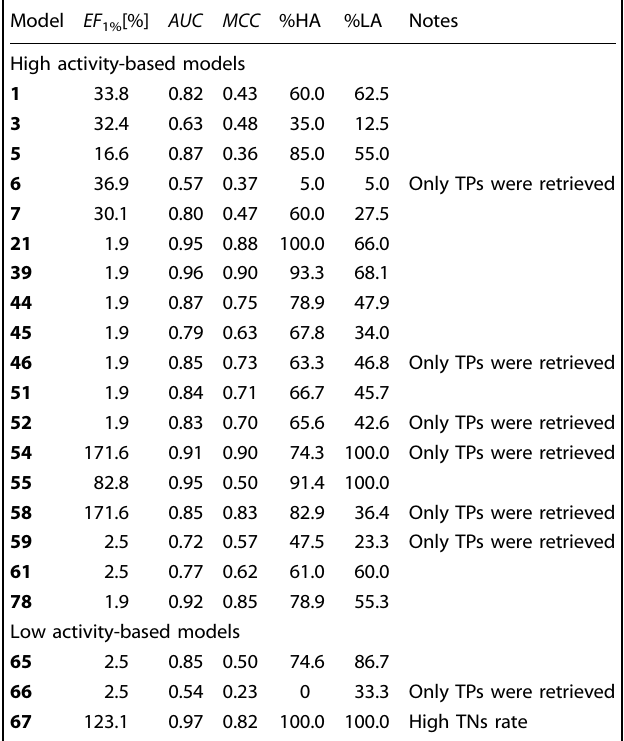
Table 4. Selected pharmacophore models created from dyes with low PCE.